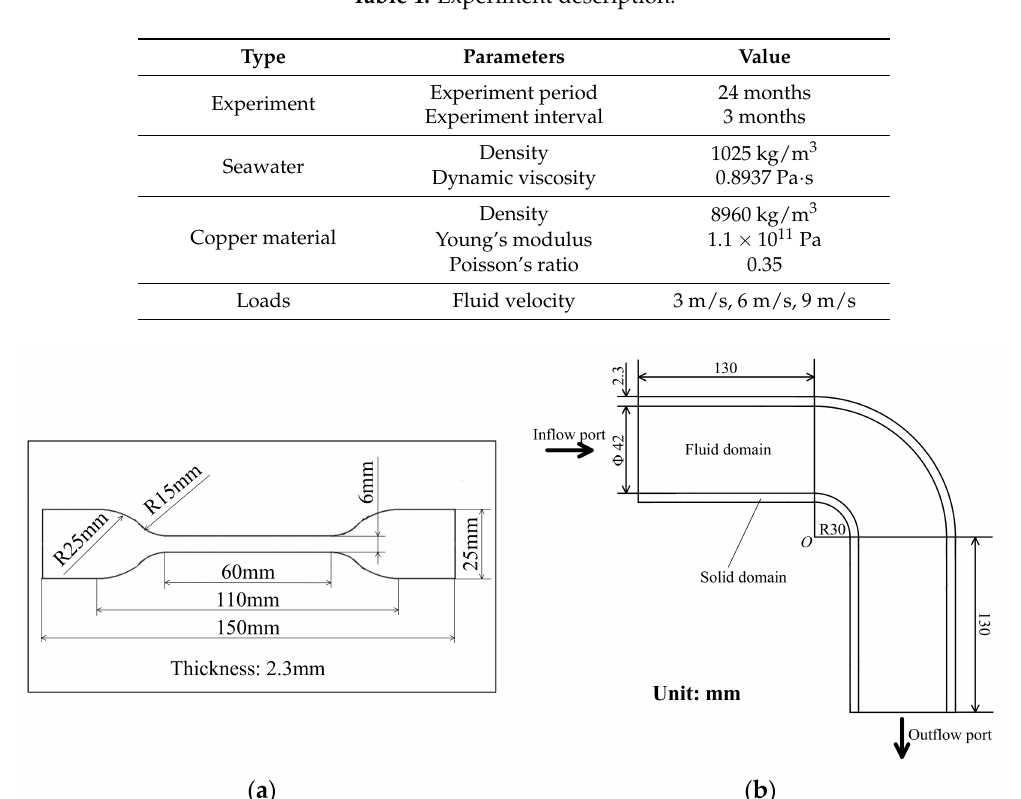
Figure 2. The dimensions of experiment sample: ( a ) the dimension of copper sample; ( b ) the dimension of copper bending